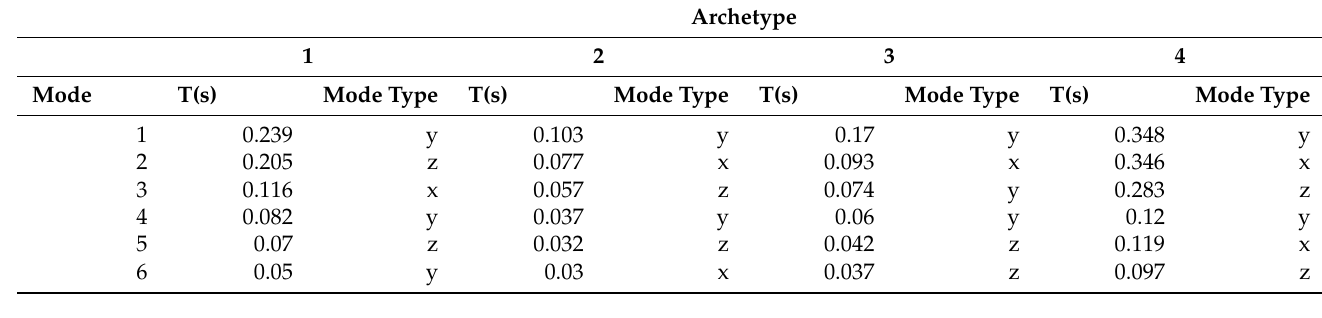
Table 3. Periods of the first six modes of vibration of the archetypes.